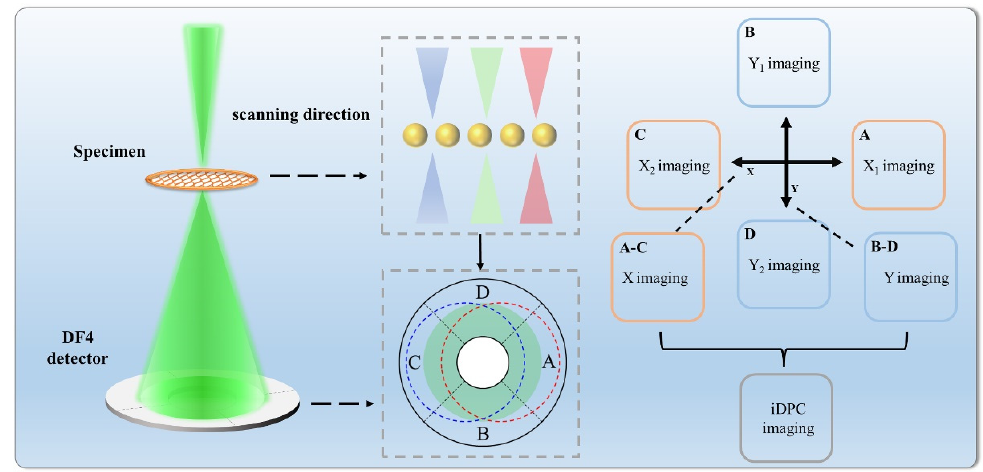
Figure 4. The schematic diagram of technical principle: partition probe, electrostatic potential imaging, and integral.